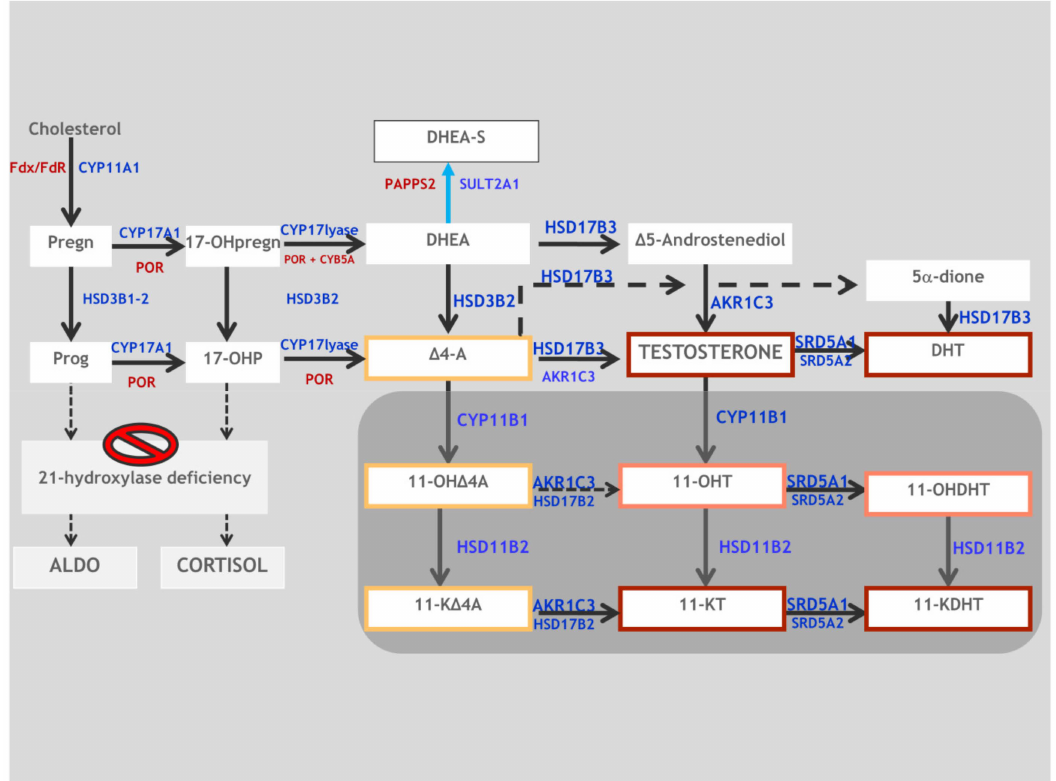
Figure 4. The metabolic pathway of classic and non-classic androgens. The grey box indicates 11-oxygenated C19 steroids. The red, orange, and yellow boxes depict steroids with strong, mild, and weak androgenic activities, respectively. HSD17B3, 17 β -hydroxysteroid dehydrogenase type 3; HSD3B2, 3 β -hydroxysteroid dehydrogenase type 2; AKR1C3, aldo-keto reductase family 1 member C3; CYP11B1, cytochrome P450 11B1; HSD11B1, 11 β -hydroxysteroid